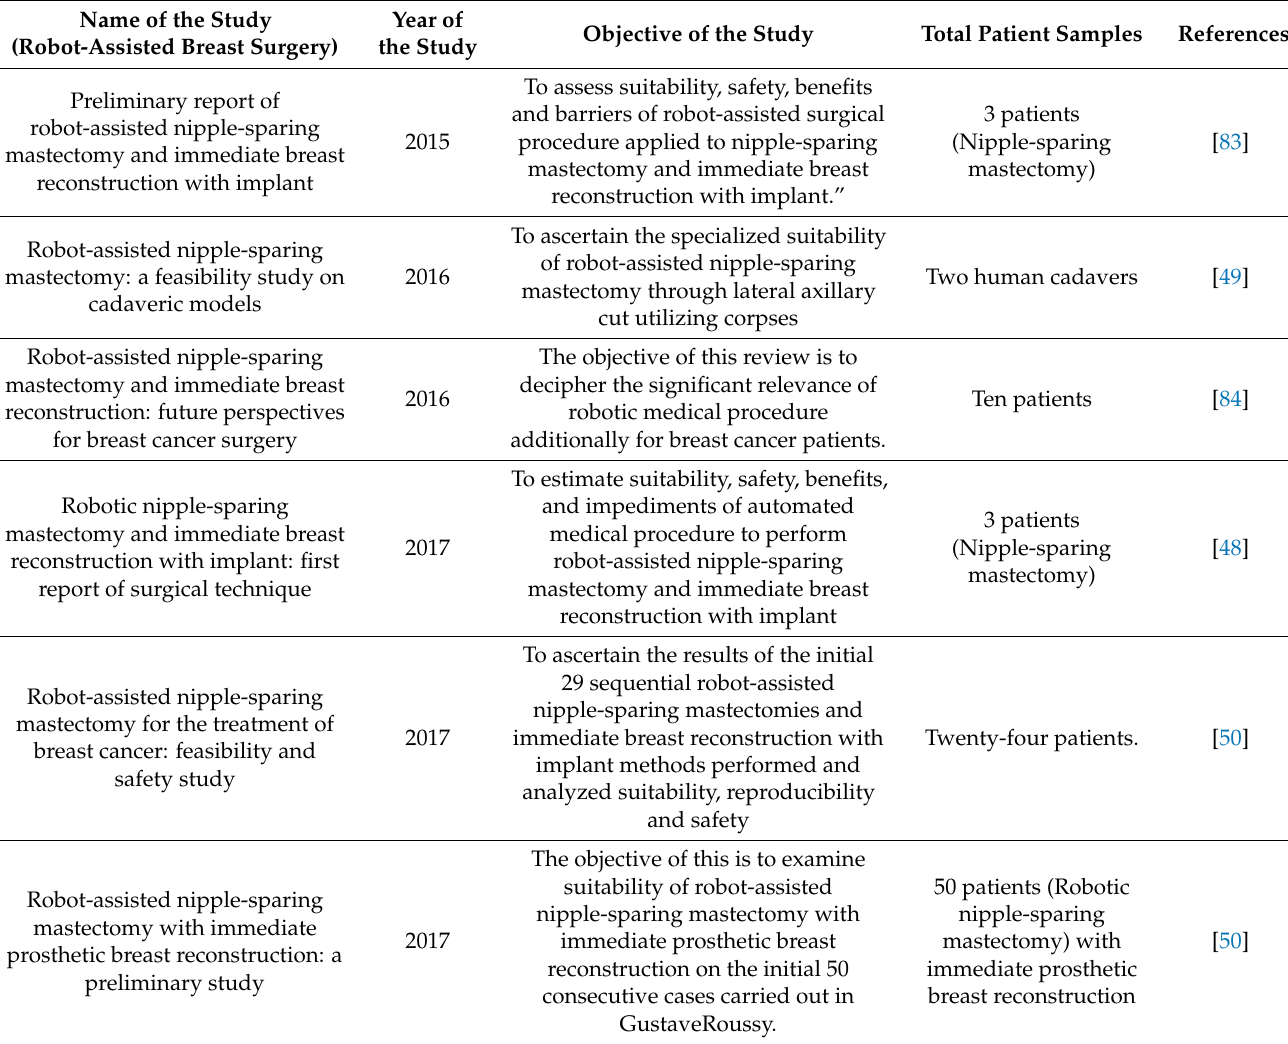
Table 3. Various studies delineating the safety, and efficacy of robot-assisted surgery in breast cancer